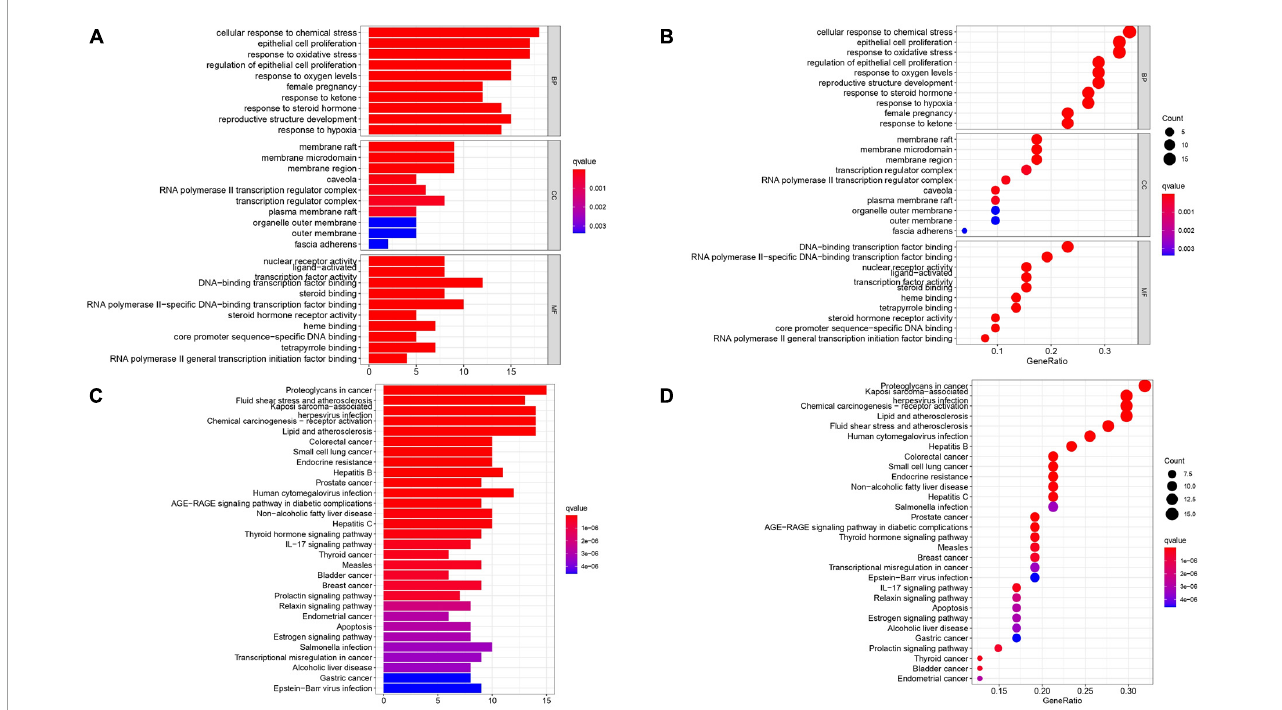
FIGURE5 Gene Ontology terms and KEGG pathway enrichment of 52 intersection targets. (A,B) The top 10 GO functional terms were selected ( P < 0.05). The spot size represented a count of genes, and color represented the q -value. (C,D) The top 30 pathways were selected ( P < 0.05). The color represents the q -value, and the abscissa represents the number of